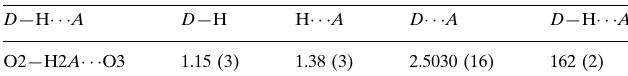
Hydrogen-bond geometry (A˚ , (cid:1)